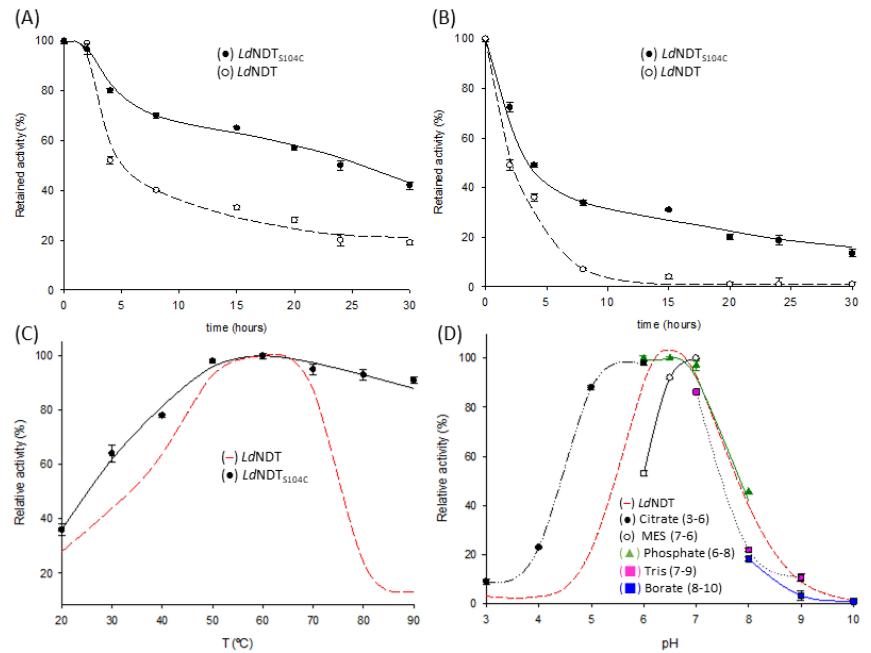
Figure 4. Thermal inactivation profile of Ld NDT and Ld NDT S104C at different temperatures in 10 mM sodium phosphate, pH 7.0. ( A ) 55 °C. ( B ) 60 °C. ( C ) Temperature profile for Ld NDT S104C . ( D ) pH profile for Ld NDT S104C . All determinations were carried out in triplicate, and the standard error of the mean is calculated using the standard deviation.